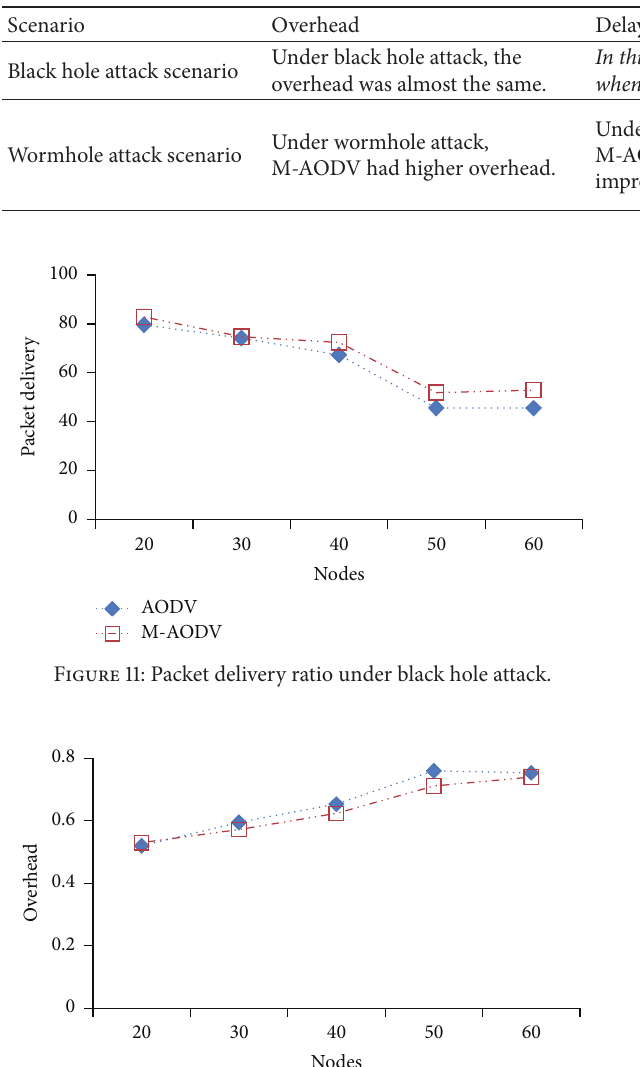
Table 5: Evaluation of the results under attack.